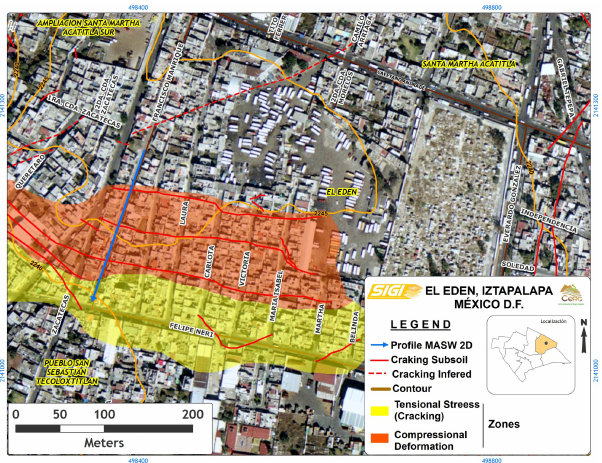
Figure 4. Location of “El Eden” Study Site in Iztapalapa. Orange colour indicate the tension area and the yellow colour the compres- sive area. Fractures are shown as red